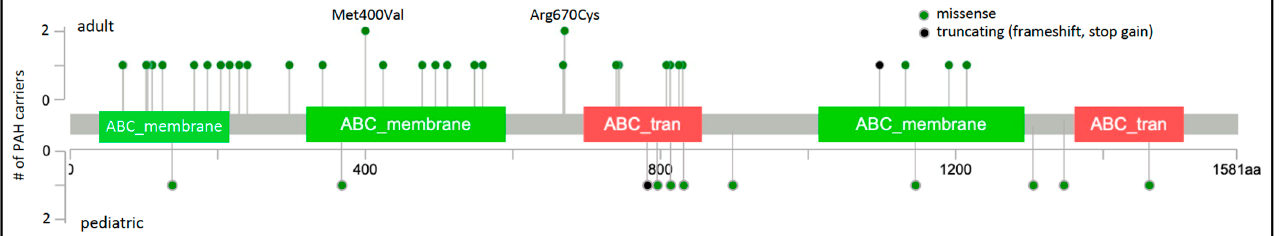
Figure 1. ABCC8 two-dimensional protein schematic. Variants identified in adult-onset PAH cases are shown above the protein schematic; variants identified in children are shown below. Variant type is color-coded. The number of PAH carriers identified with a particular variant is shown along the y -axis. Note that splice variants are not included and variant density may impede visualization of closely-located variants. Conserved protein domains are indicated by colored rectangles.